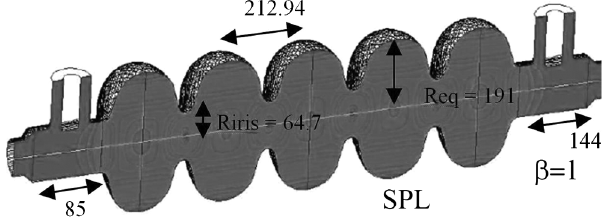
FIG. 11. 704 MHz SPL cavity and characteristic dimensions.